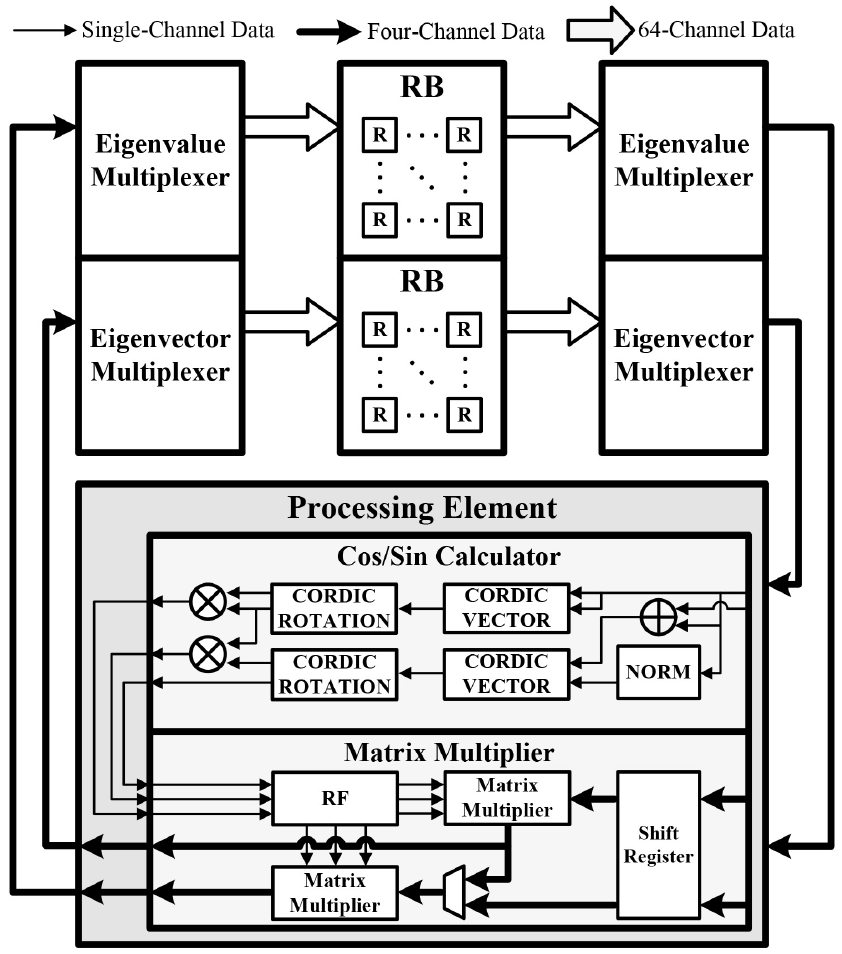
Figure 8. Hardware architecture of eigenvalue decomposition module